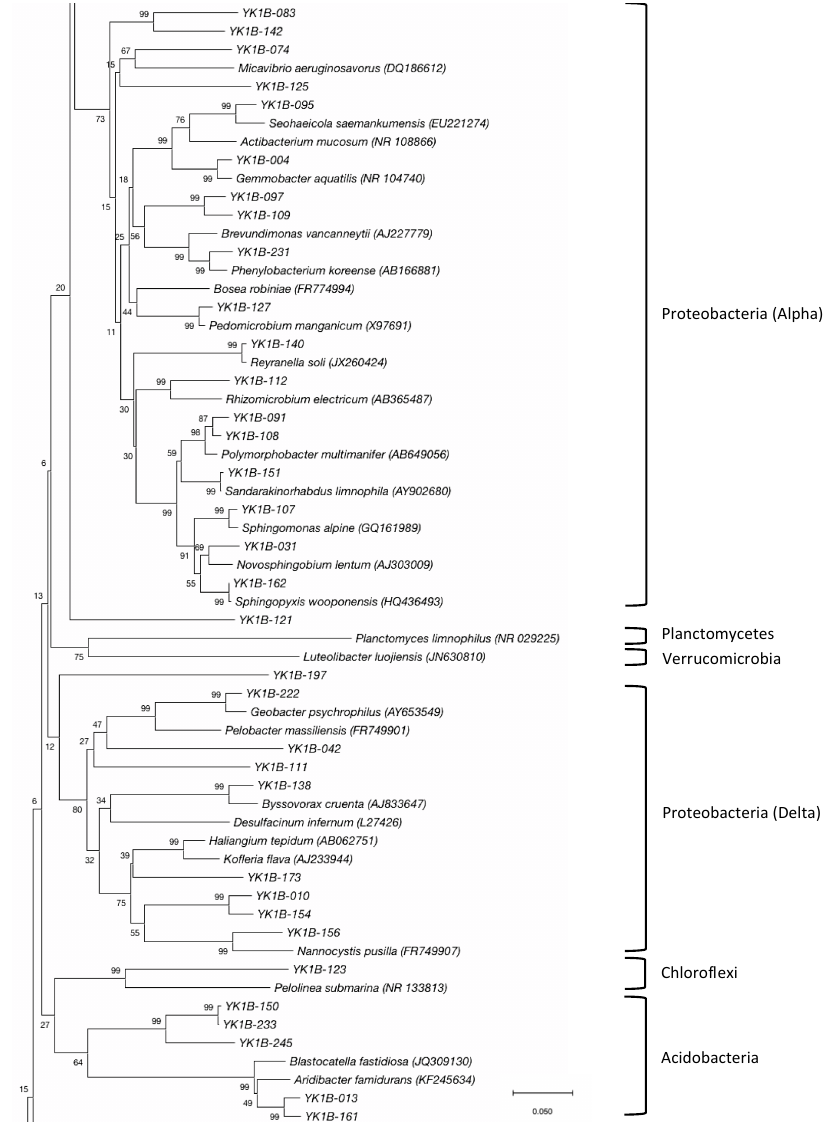
Figure 6. Phylogenetic tree of Alpha- and Delta-proteobacteria, Chloroflexi and Acidobacteria clones. The DNA database accession numbers for described species are in parentheses. The bar indicates evolutionally distance. The bootstrap value of each node is indicated.